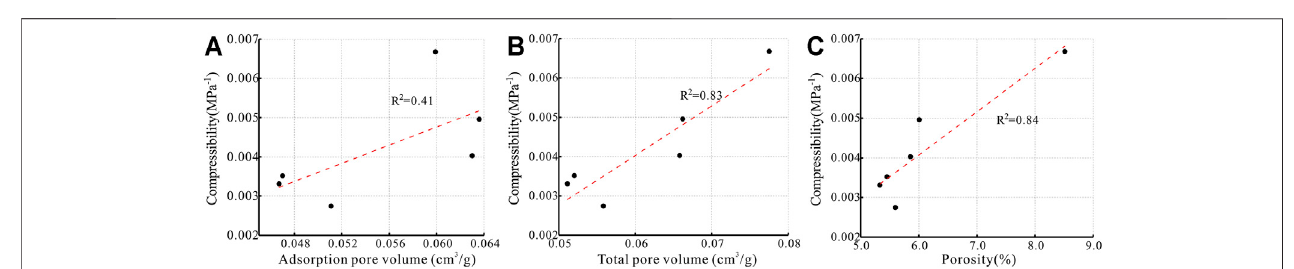
FIGURE 9 | Relationship between adsorption pore volume, total pore volume, porosity, and compressibility.